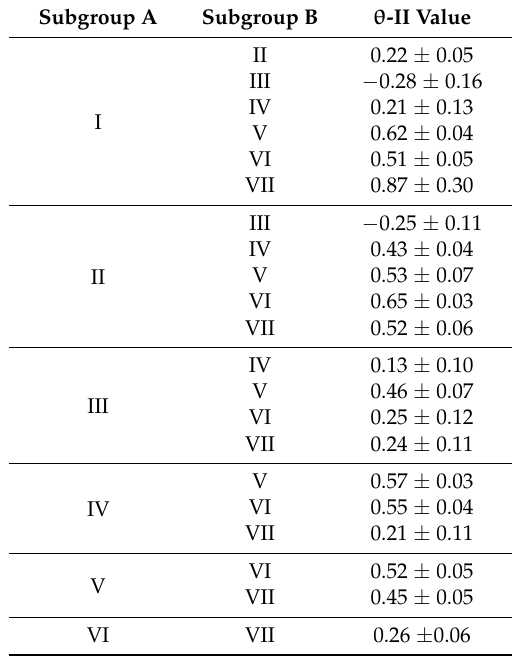
Table 3. Estimation of type II functional divergence ( θ ) using type II of DIVERGE